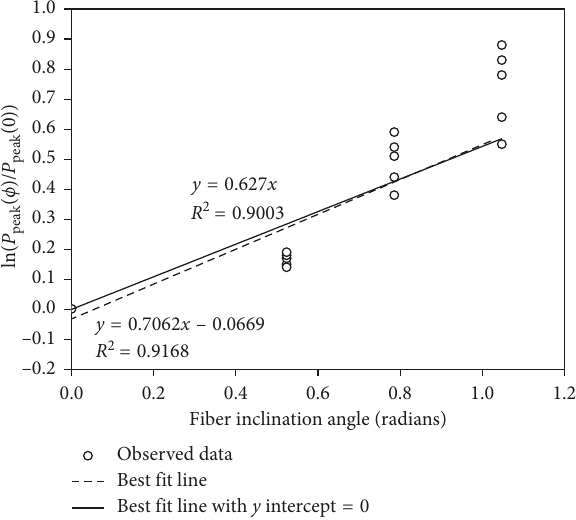
Figure 9: Deduction of snubbing coefficient f using inclined PE fiber pullout